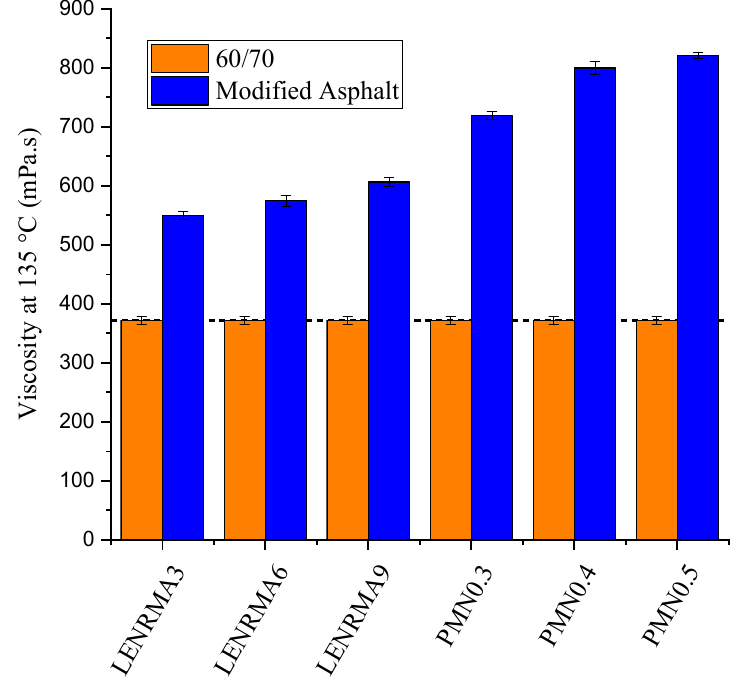
Figure 4. Rotational viscosity of all binders.